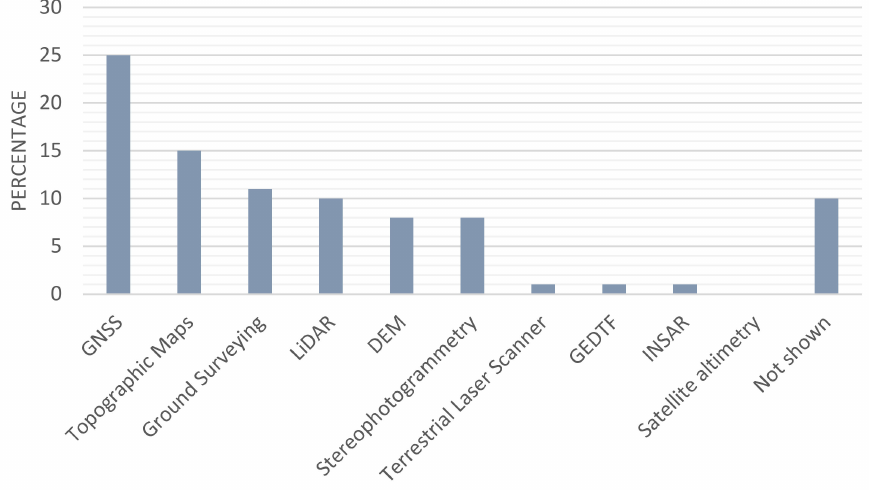
Figure 7. Percentage distribution of reference data sources.